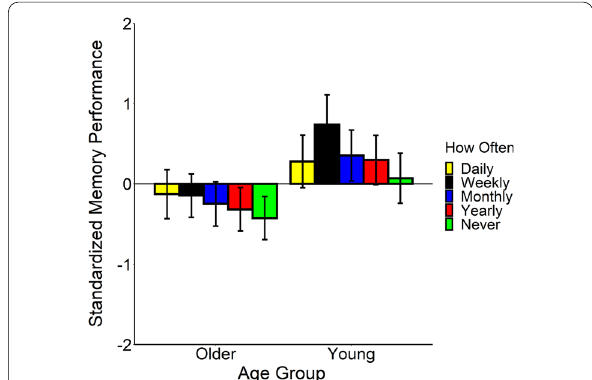
Fig. 6 Average event memory performance as a function of how often older and young adults performed the activity. Participants remembered more when they performed the activity daily than if they performed the activity monthly, yearly, or